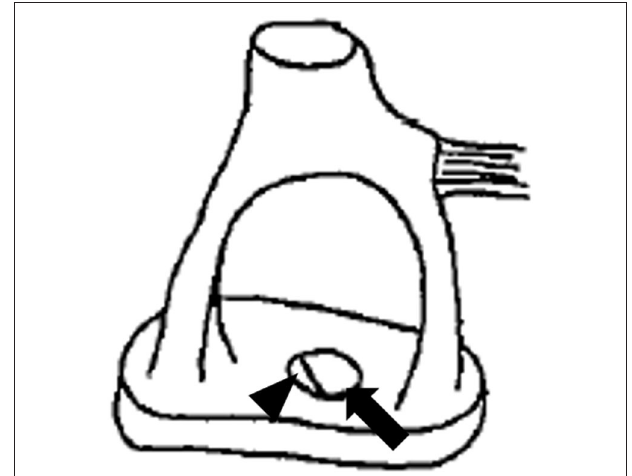
FIGURE 3 | Illustration depicting the anomalous stapes footplate. The arrow illustrates the bony defect, while the arrowhead illustrates a tear in the membranous stapes